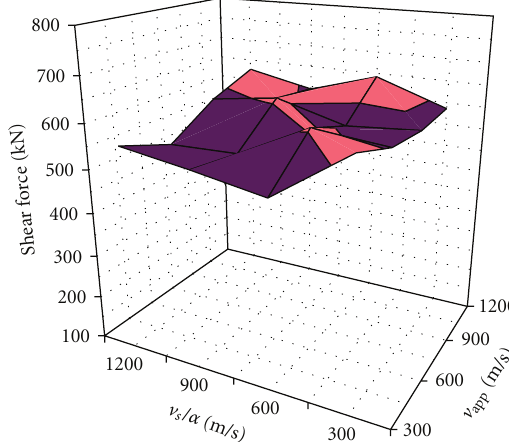
Figure 16: Transverse direction: maximum shear